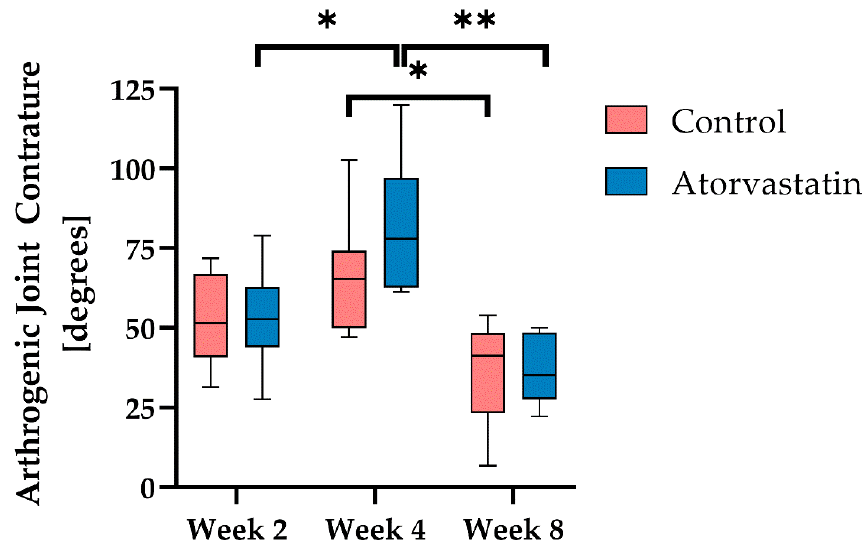
Figure 5. Arthrogenic joint contracture at weeks 2, 4 (immobilization) and 8 (remobilization); n = 8 per group and time point, and n = 7 only in control after 8 weeks. Data are presented as boxplots with median, minimum and maximum (*: p < 0.05, **: p < 0.001).